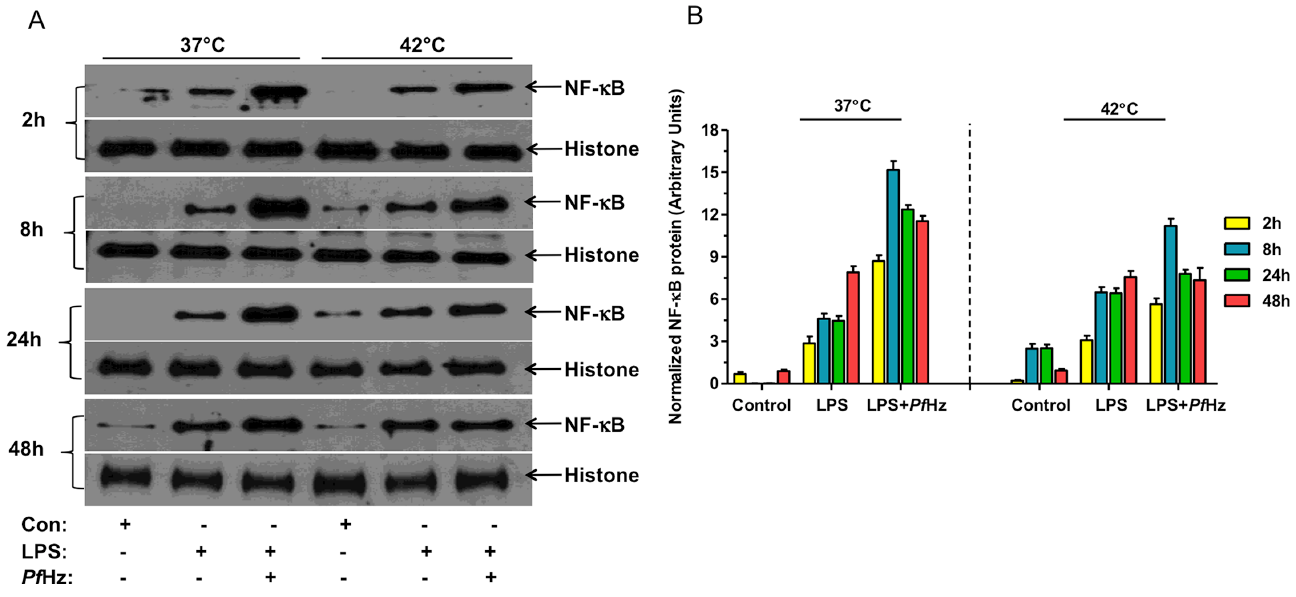
Figure 4. Effect of Pf Hz and heat shock treatment on NF- κ B translocation into the nucleus. Peripheral blood mononuclear cells (2.5 × 10 6 ) were incubated for 2 h at either 37°C (physiological) or 42°C (heat shock treatment) and stimulated with LPS for 1 h. Cells were treated with Pf Hz (10 μ g/mL) and incubated for different time points (2 to 48 h). (A) Nuclear extracts were prepared after harvesting cells and equal amounts of protein were loaded on 4-20% SDS-PAGE to determine the amount of nuclear translocated NF- κ B by immunoblotting. In addition, a nuclear marker (histone protein) was quantified to account for protein loading (control). (B) Densitometry analysis after normalizing the respective bands against histone (n = 3); error bars represent SEM.